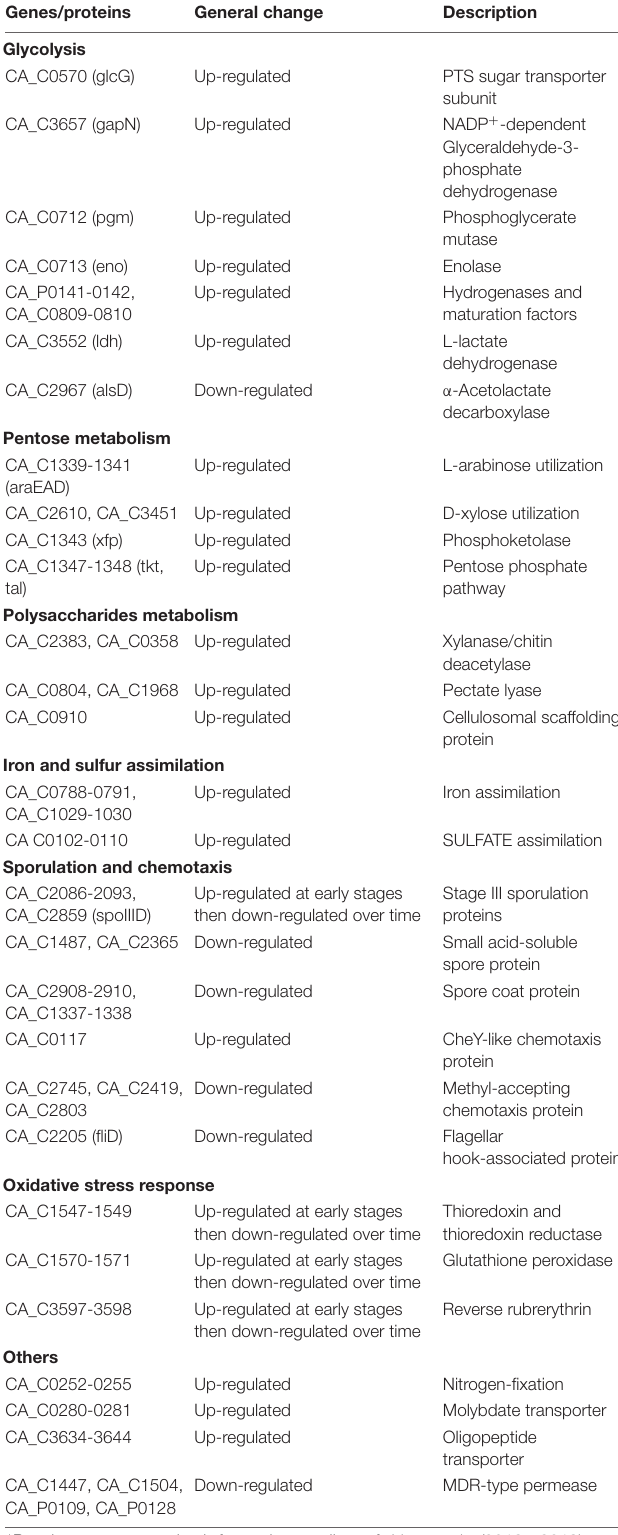
TABLE 1 | Some genes/proteins differentially regulated in C. acetobutylicum